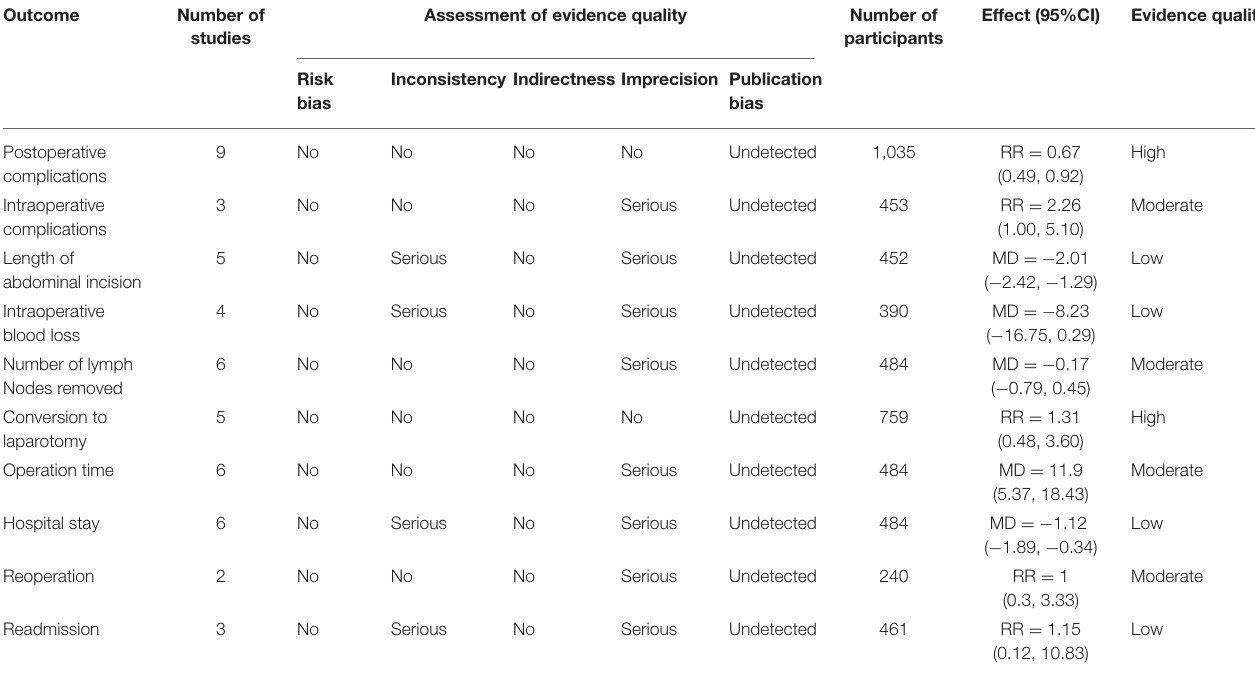
TABLE 4 | GRADE evidence profile of